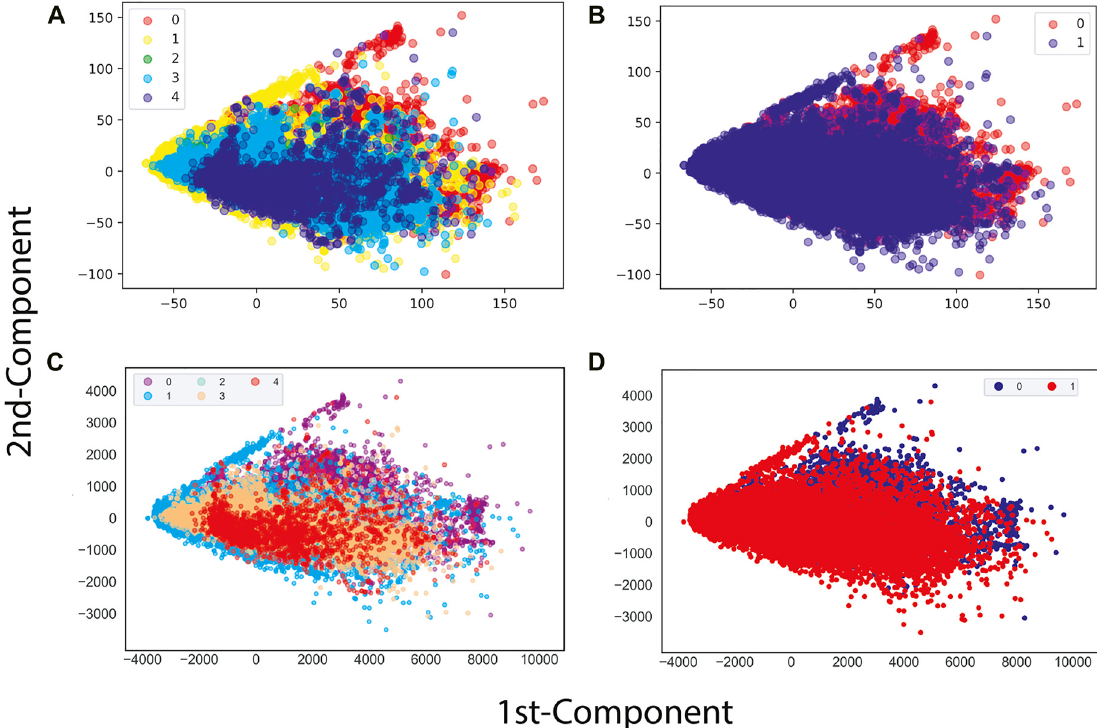
Figure 3: Graph of the two main components of the LTR-RT dataset: (A) PCA with five labels 0: curated sequences, 1: elements with domains belonging to two different superfamilies, 2: elements presenting domains from two or more lineages, 3: elements with lengths different from those reported in the literature, 4: elements that have TE Class II insertions, (B) PCA with 2 labels 0: curated sequences and 1: the union of classes 1, 2, 3 and 4, (C) t-SNE with the specifications of (A) and (D) t-SNE with the specifications of (B).